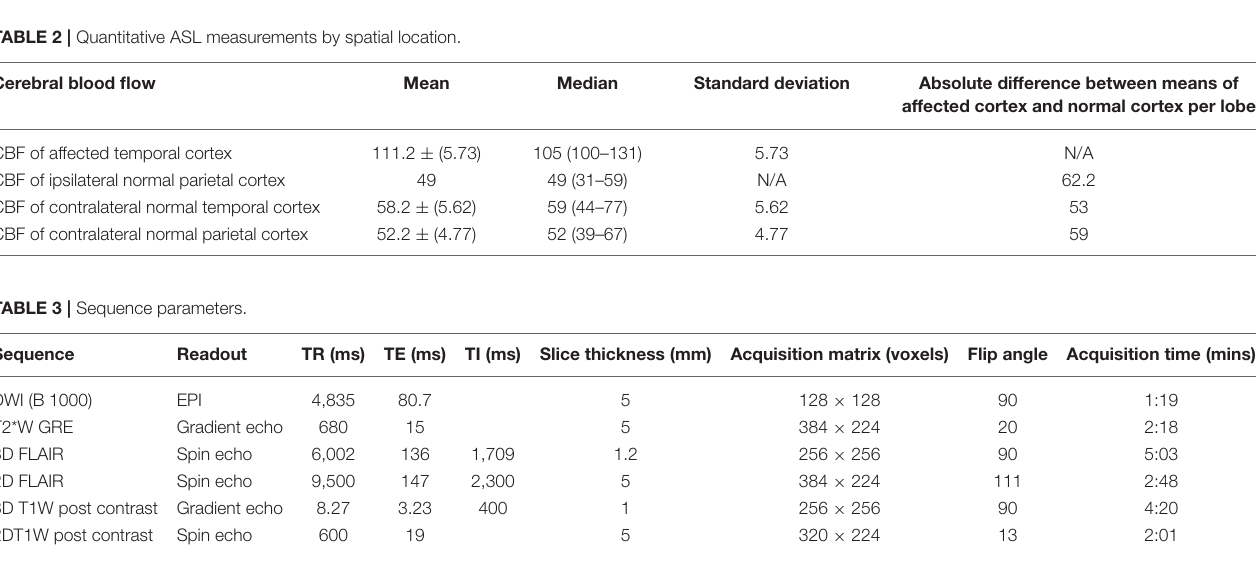
FIGURE 7 | A 54 year old male with traumatic brain injury. (A) Initial ASL at the level of the parietal cortex shows normal cerebral blood flow bilaterally. (B) ASL demonstrates hyperperfusion within the left hippocampus when compared to the normal contralateral mesial temporal lobe. (C) 8 month follow up at the level of the parietal cortex demonstrates normal cerebral blood flow bilaterally. (D) 8 month follow up ASL shows resolution of the previous left hippocampal hyperperfusion with cerebral blood flow similar to the normal contralateral side.